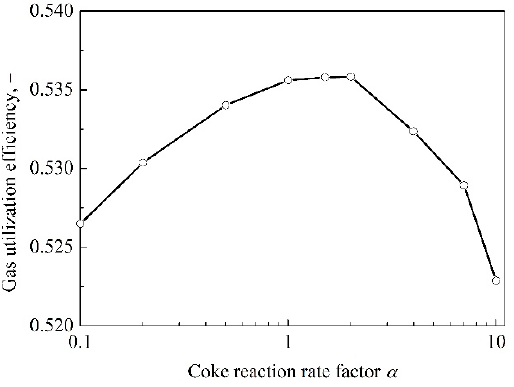
Figure 3. The relationship between the gas utilization efficiency and coke reactivity.